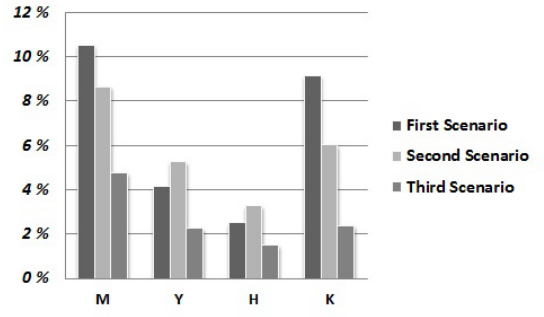
Fig. 14. The target keeping rate in each trials with three different